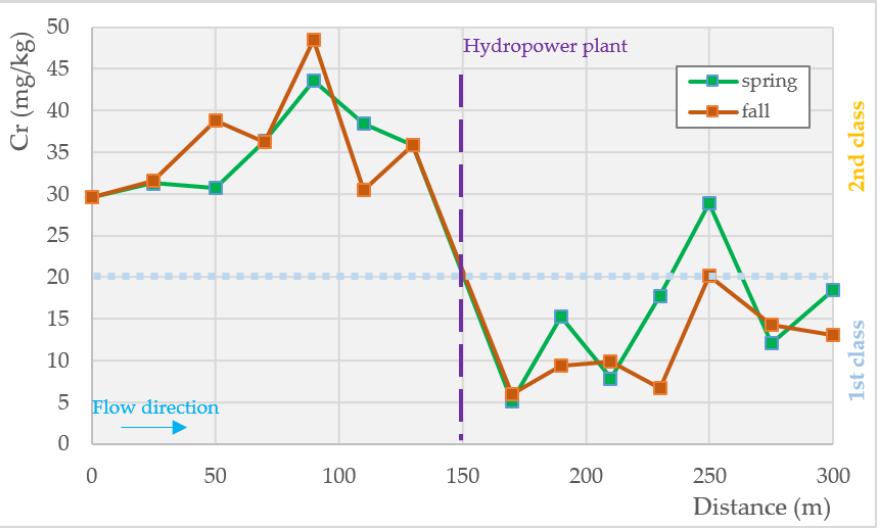
Figure 7. Changes in chromium concentrations in sediments in spring and fall near the hydropower plant on the Ślęza River, along with the geochemical classification.